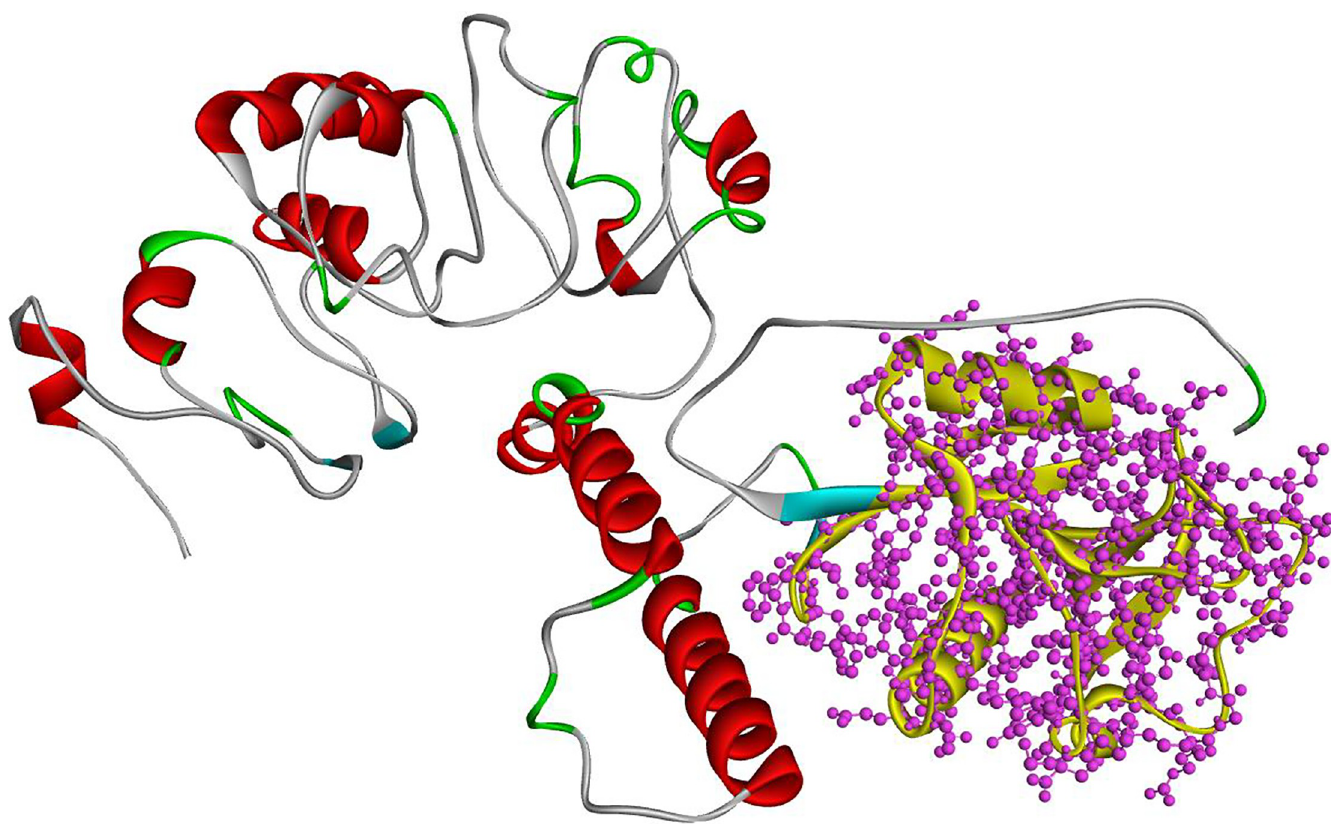
Fig 1. Receiver Operator Characteristic (ROC) curves for 3 logistical regression models. Full model (blue curve): PCFA2 and ZCA-cor composite scores are predictors. PCFA2 Model (red curve). ZCA-cor Model (green curve).